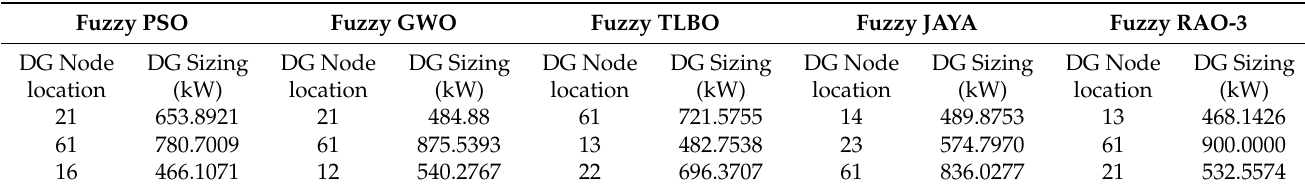
Table 7. DG optimum location and sizing.